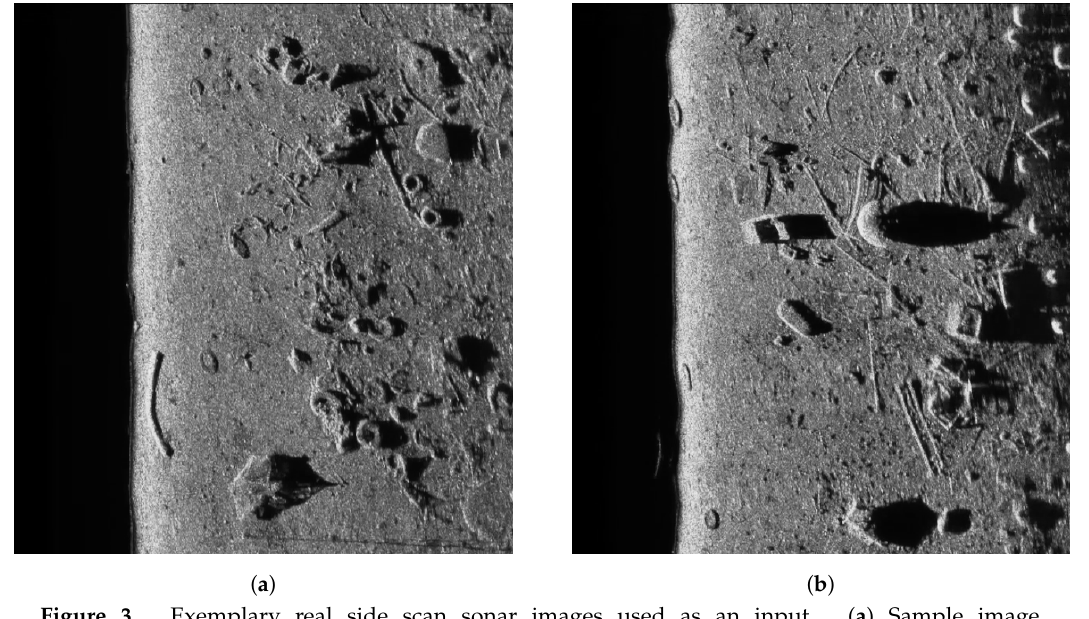
Figure 3. Exemplary real side scan sonar images used as an input. ( a ) Sample image containing man-made circular objects (tyres); ( b ) Sample image containing man-made circular and box-shaped